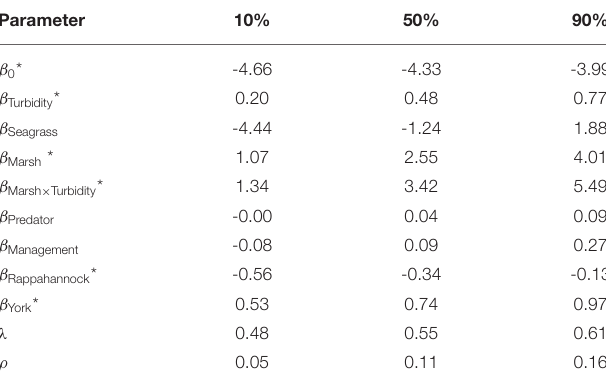
TABLE 4 | Posterior summary statistics (median and 80% Bayesian CI’s) of regression coefficients β as well as autocorrelation parameters λ (spatial) and ρ (temporal) from Model